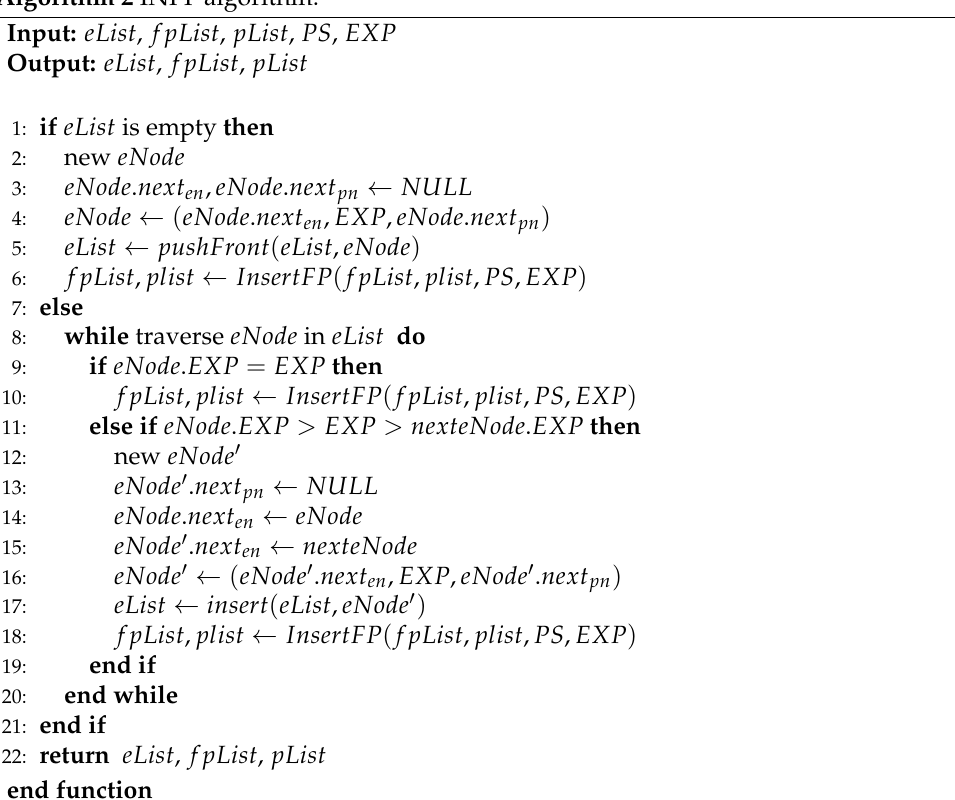
Figure 8. Insert the new pseudonym and fingerprint algorithm. Algorithm 2 INPF